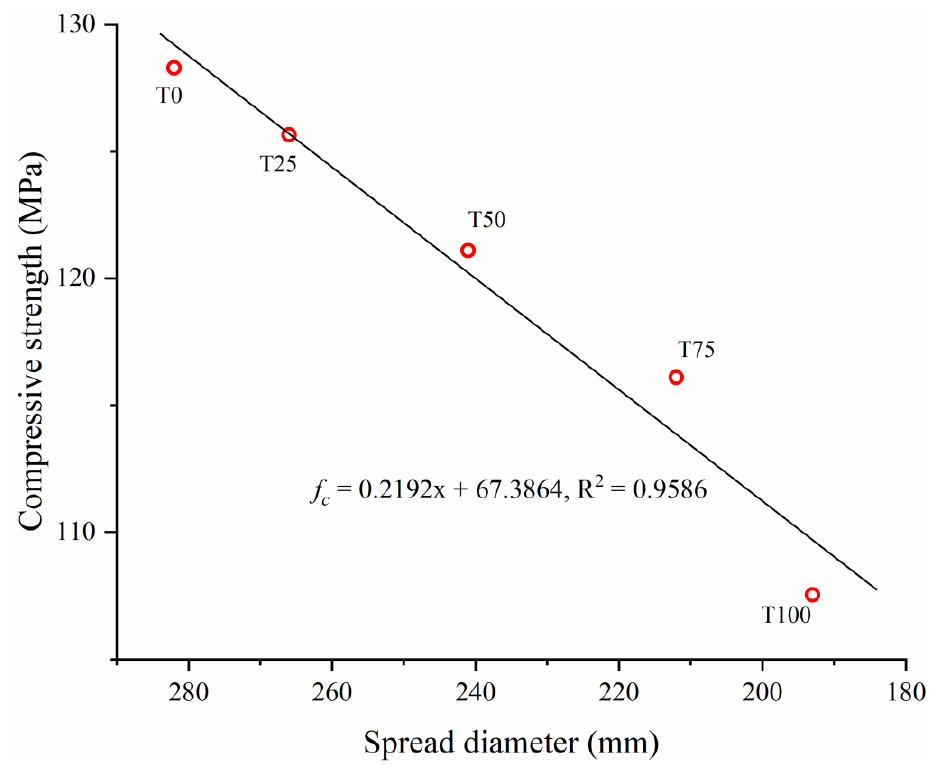
Figure 12. Relationship between workability and compressive strength of UHPC.